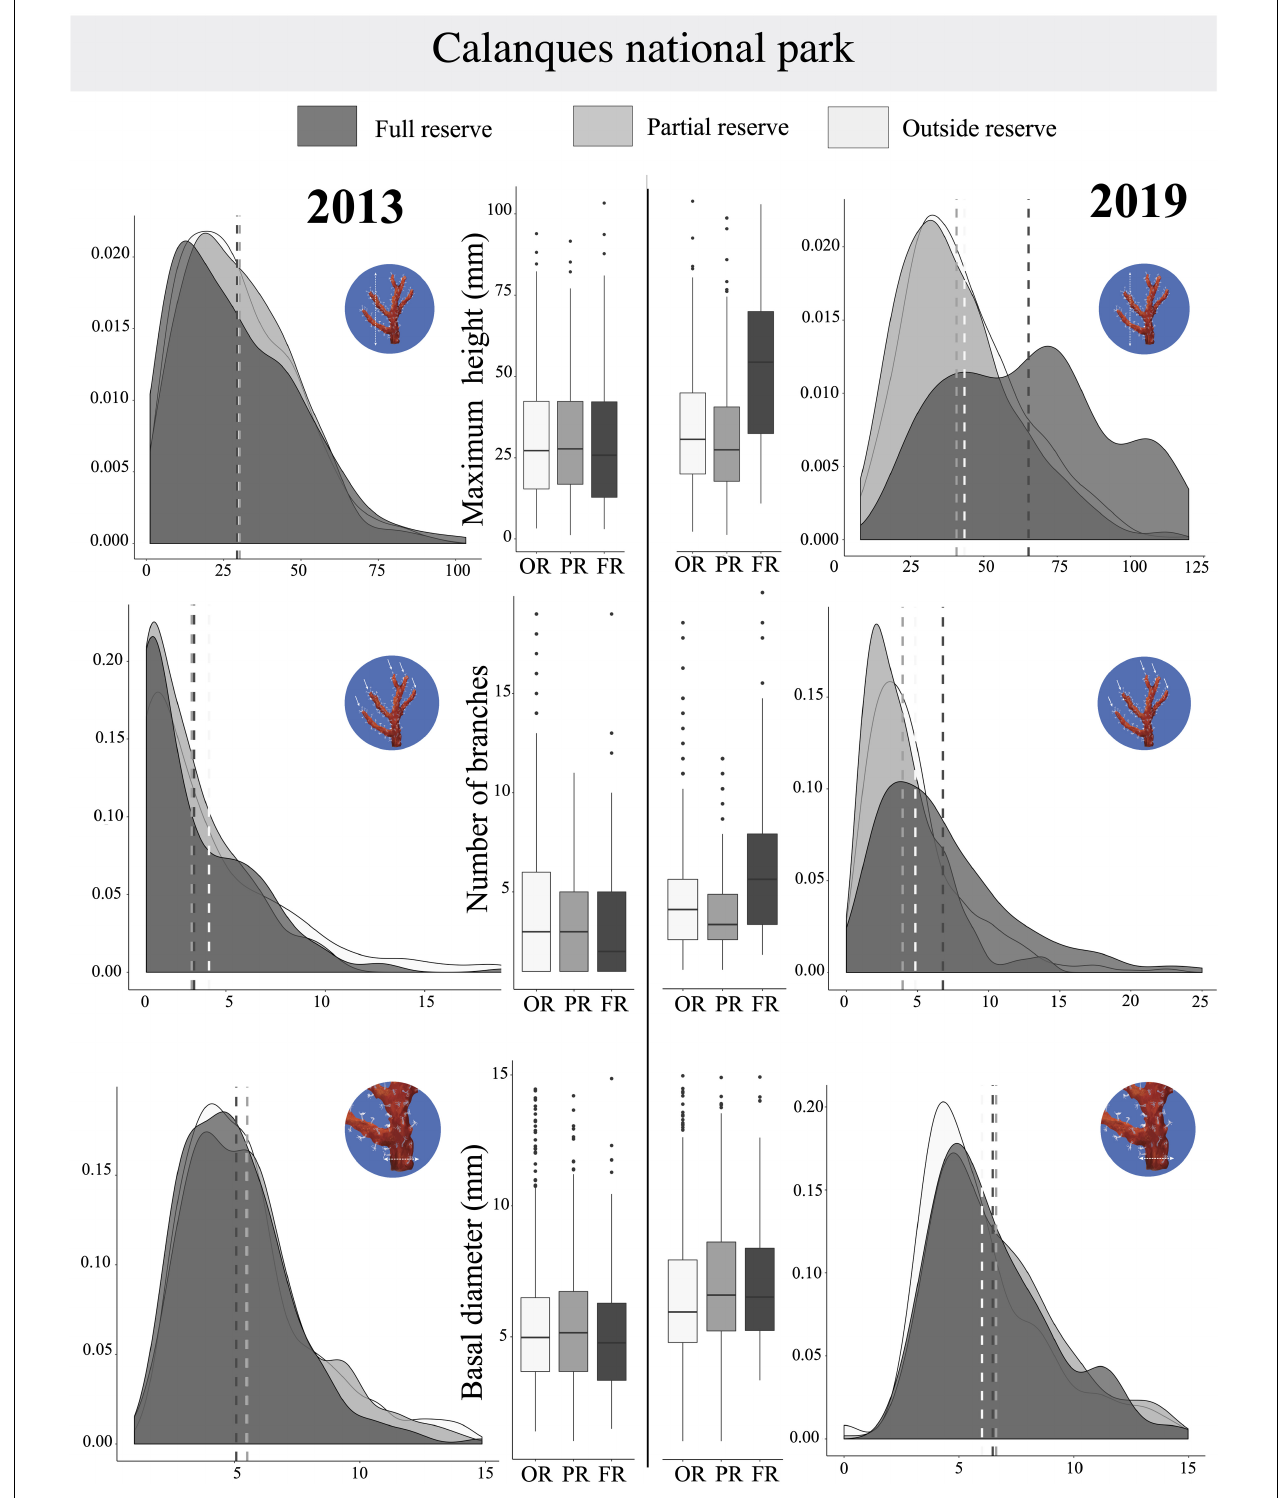
FIGURE 9 | For Calanques National Park, representation of probability density functions and Tuckey boxplots by protection levels for each year for the variables (i) Maximum height (mm), (ii) Number of branches, and (iii) Basal diameter (mm). Sites outside reserve (in clear), in partial reserve (in medium gray), in full reserve (in dark). On density functions, mean are shown in a dotted line; Boxplots indicate the median (bold line near the center), the first and third quartile (the box), the extreme values where distance from the box is at most 1.5 times the inter-quartile range (whiskers), and remaining outliers (dark circles).